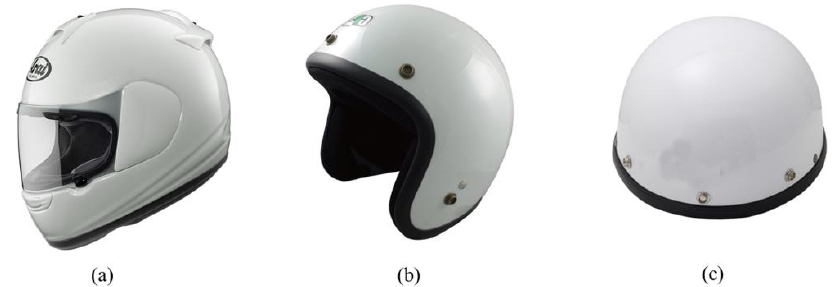
Figure 1. Motorcycle helmet designs: ( a ) full-face; ( b ) open-face; and ( c ) half.